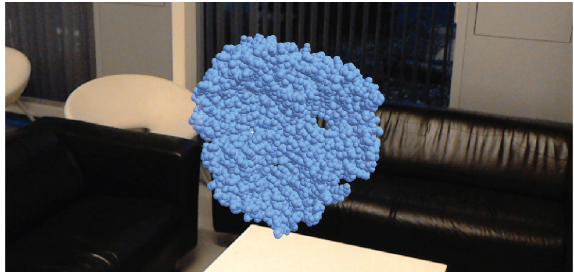
Figure 3: Live capture from the Unity prototype showing one of the protein data sets used for testing (PDB ID: 1AF6).